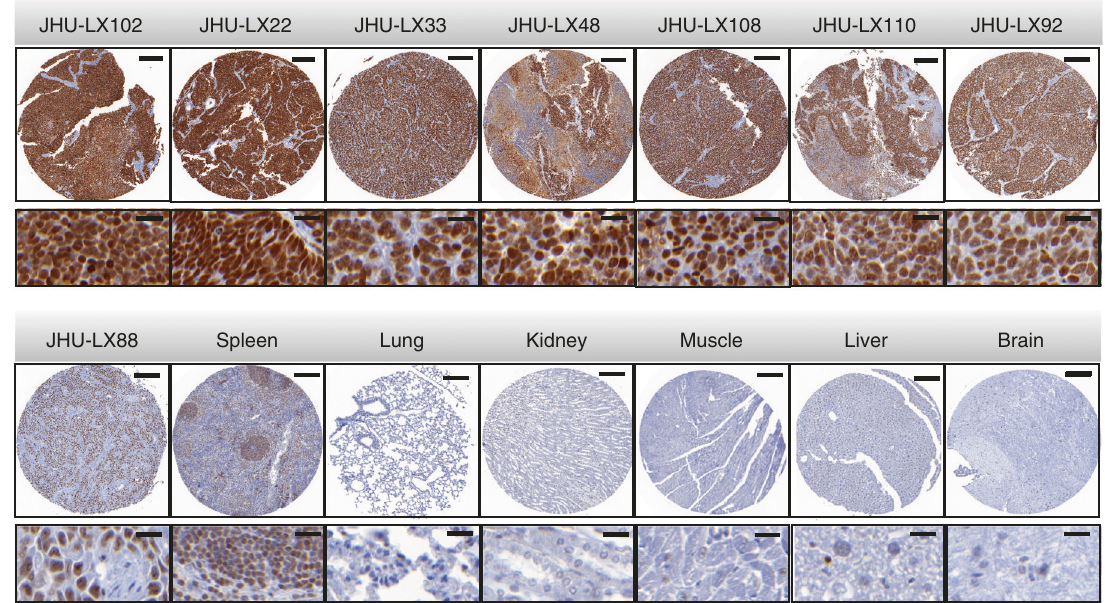
Fig. 2 PARP expression in PDX lines. PARP1 expression was assessed via immunohistochemistry staining on tissue microarrays (TMAs) in eight PDX lines which were grown as xenografts in NSG mice and fi ve normal control tissues (spleen, lung, kidney, muscle, liver, and brain). Scale bar represents 200 µ m (whole core) and 20 µ m (inset). All PDX lines show high PARP1 expression. All PDX lines are SCLC, except JHU-LX88, which is squamous cell lung cancer. These tumors showed lower PARP1 expression than all seven SCLC PDX lines and also showed lower expression than spleen, which has a naturally